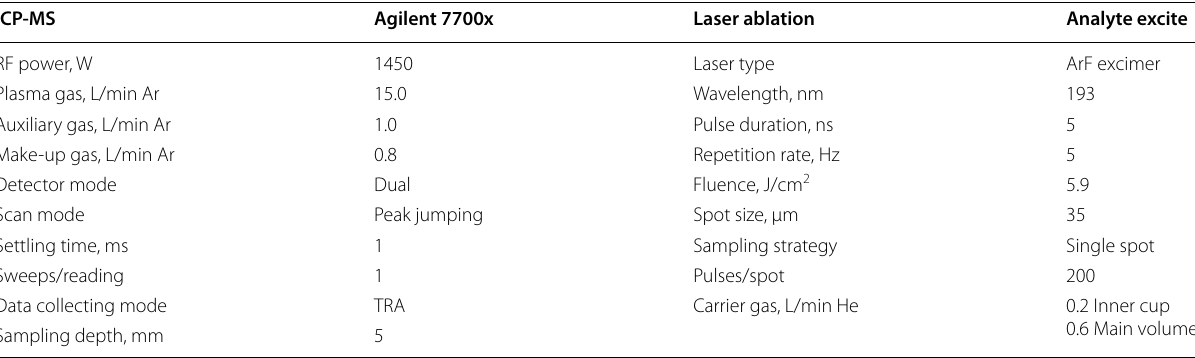
Table 1 Operating parameters for LA-ICP-QMS in this work